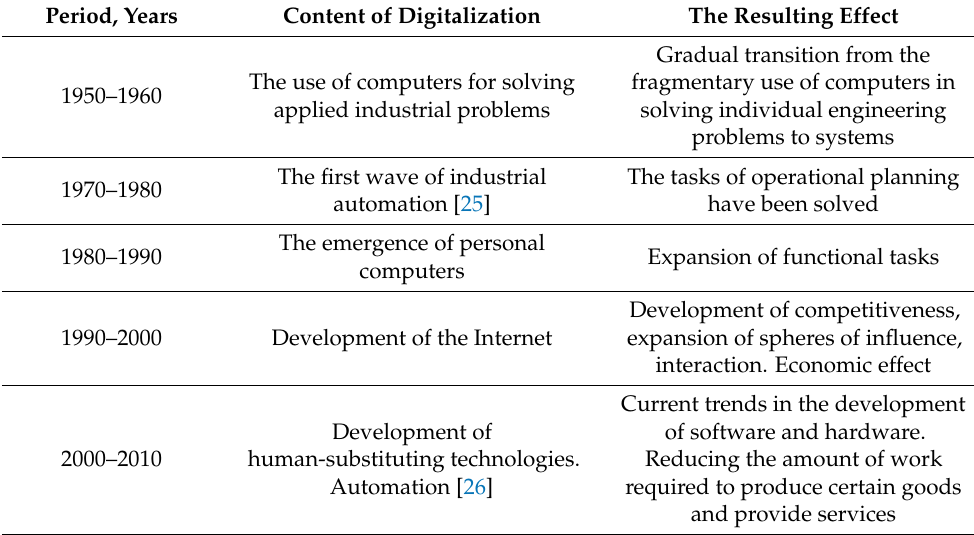
Table 1. Stages of digitalization of energy in Russia (developed by the